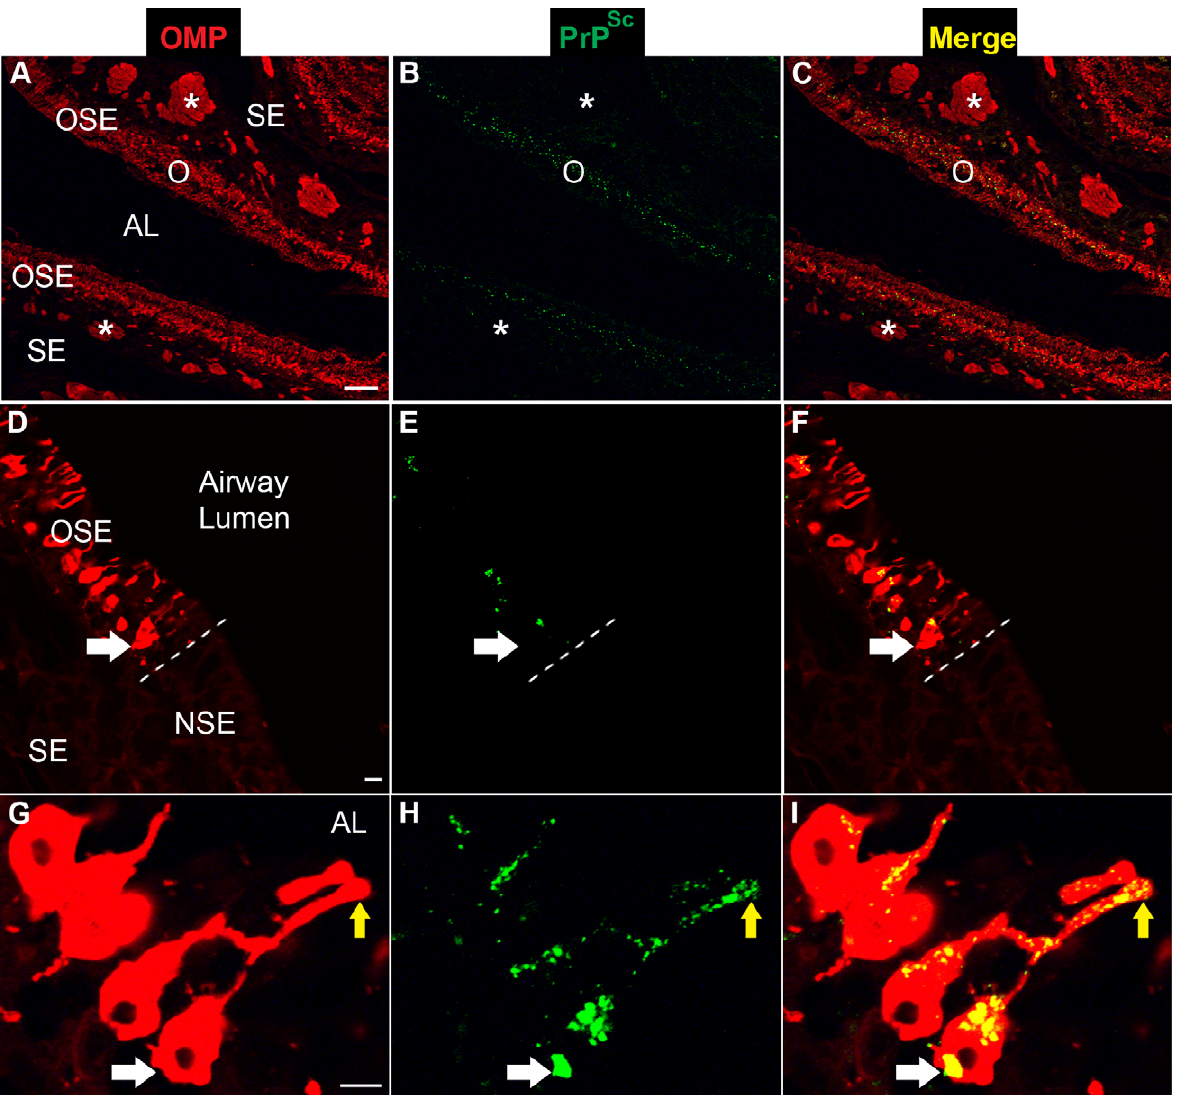
Figure 4. Distribution of PrP Sc in olfactory sensory epithelium following intra-olfactory bulb inoculation of the HY TME agent. Laser scanning confocal microscopy of olfactory marker protein (OMP)( A , D , G ), PrP Sc ( B , E , H ), and for both OMP and PrP Sc (Merge)( C , F , I ). Panels A through C , D through F , and G through I are the same field of view. In A to C , the olfactory sensory epithelium (OSE or O) and nerve bundles (*) in the subepithelial layer (SE) express high levels of OMP and the airway lumen (AL) is observed between two opposing OSEs in the nasal turbinate. In D to F , the OSE is distinct from the nonsensory epithelium (NSE) by the presence of OMP and is separated by a dashed white line at the border between the two epithelial layers. The soma of an olfactory receptor neuron (ORN) in the OSE is identified by a white arrow and PrP Sc was only observed in OMP-positive ORNs and not in the NSE. In G to I , the white arrow points to the soma of an OMP-positive ORN and the yellow arrow indicates the apical dendrite of an OMP-positive ORN, which sits adjacent to the airway lumen ( G ). PrP Sc was present in both the soma and dendrites of ORNs ( H , I ). Immunofluorescence staining and LSCM were performed as described above. Scale bar is 100 m m in A and 10 m m in D and G . doi:10.1371/journal.ppat.1000837.g004 and apical dendrites of individual OMP-positive cells (Figure 4G to 4I). A three-dimensional reconstruction of an apical dendritic knob revealed PrP Sc deposition within this structure (Video S1), but PrP Sc deposition was not observed in the dendritic knobs of ORNs from normal, mock-infected hamsters in the nasal cavity (Video S2) or in other locations in the subepithelial layer of HY TME infected hamsters including the Bowman’s gland, which secretes mucus into the nasal passages. It was occasionally reported [23].